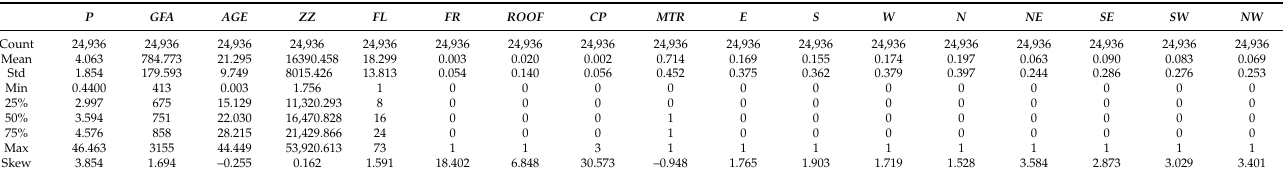
Figure 2. Correlation Matrix. Table 2. Descriptive